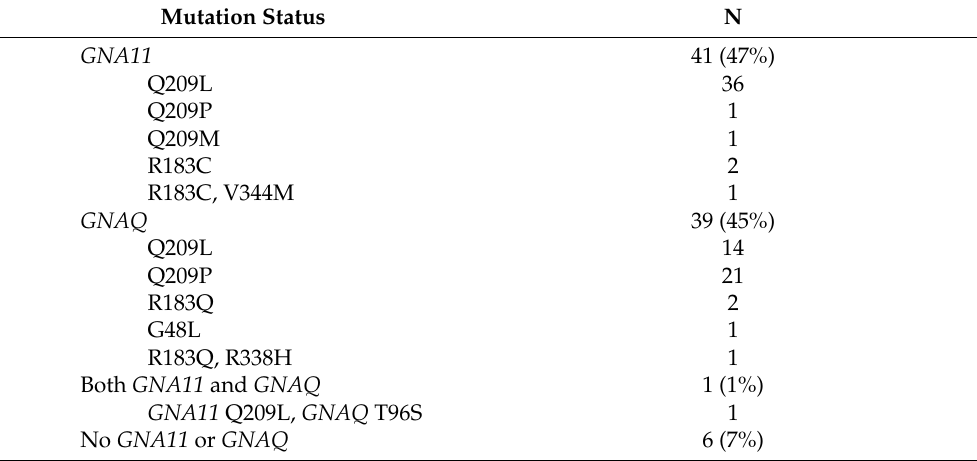
Table 2. Frequency of mutations in the two major genes in metastatic uveal